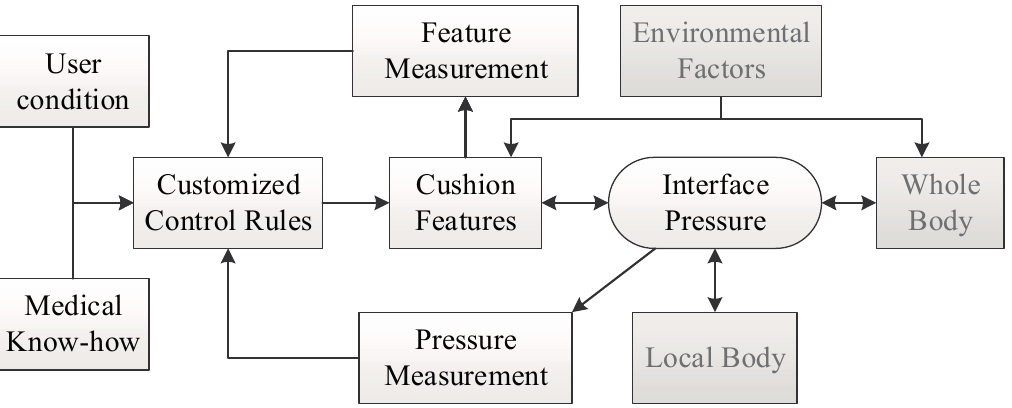
Figure 2. The system concept for real-time active pressure